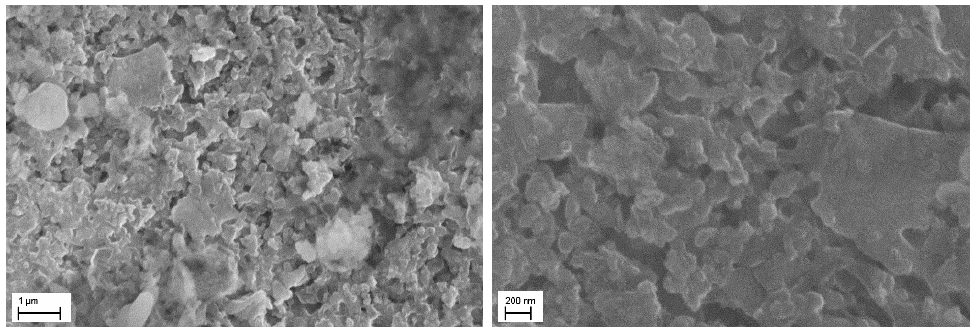
Figure 3. SEM images of the Li 3 V 2 (PO 4 ) 3 (86 wt%)/Li 3 PO 4 (14 wt%) composite surfaces after 200 charge/discharge cycles at different magnifications.